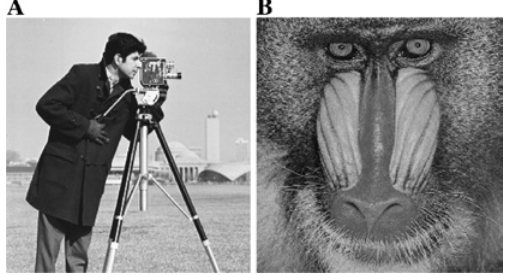
Figure 4: Original Secret Images: (A) Cameraman, (B) Baboon.